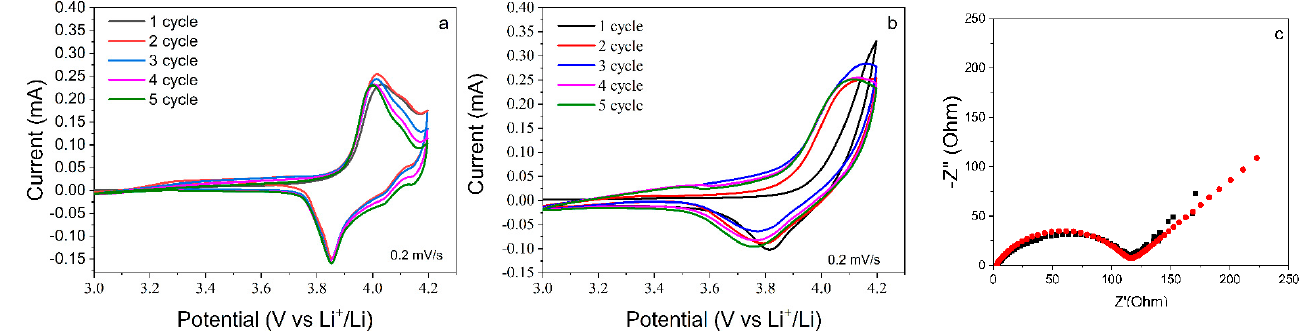
Figure 6. CV scans of LiCoO 2 thin-film cathodes annealed in Ar: ( a ) 550 °C for 1 h 20 min at ramp rate of 30 ◦ C min − 1 ; ( b ) 550 ◦ C annealed for 2 h at 30 ◦ C min − 1 ; ( c ) EIS for 550 ◦ C for 1 h 20 min at rate of 30 °C min − 1 ; ( b ) 550 °C annealed for 2 h at 30 °C min − 1 ; ( c ) EIS for 550 °C for 1 h 20 min at ramp rate of 30 ◦ C min -1 before cycling at discharge state. ramp rate of 30 °C min -1 before cycling at discharge state .